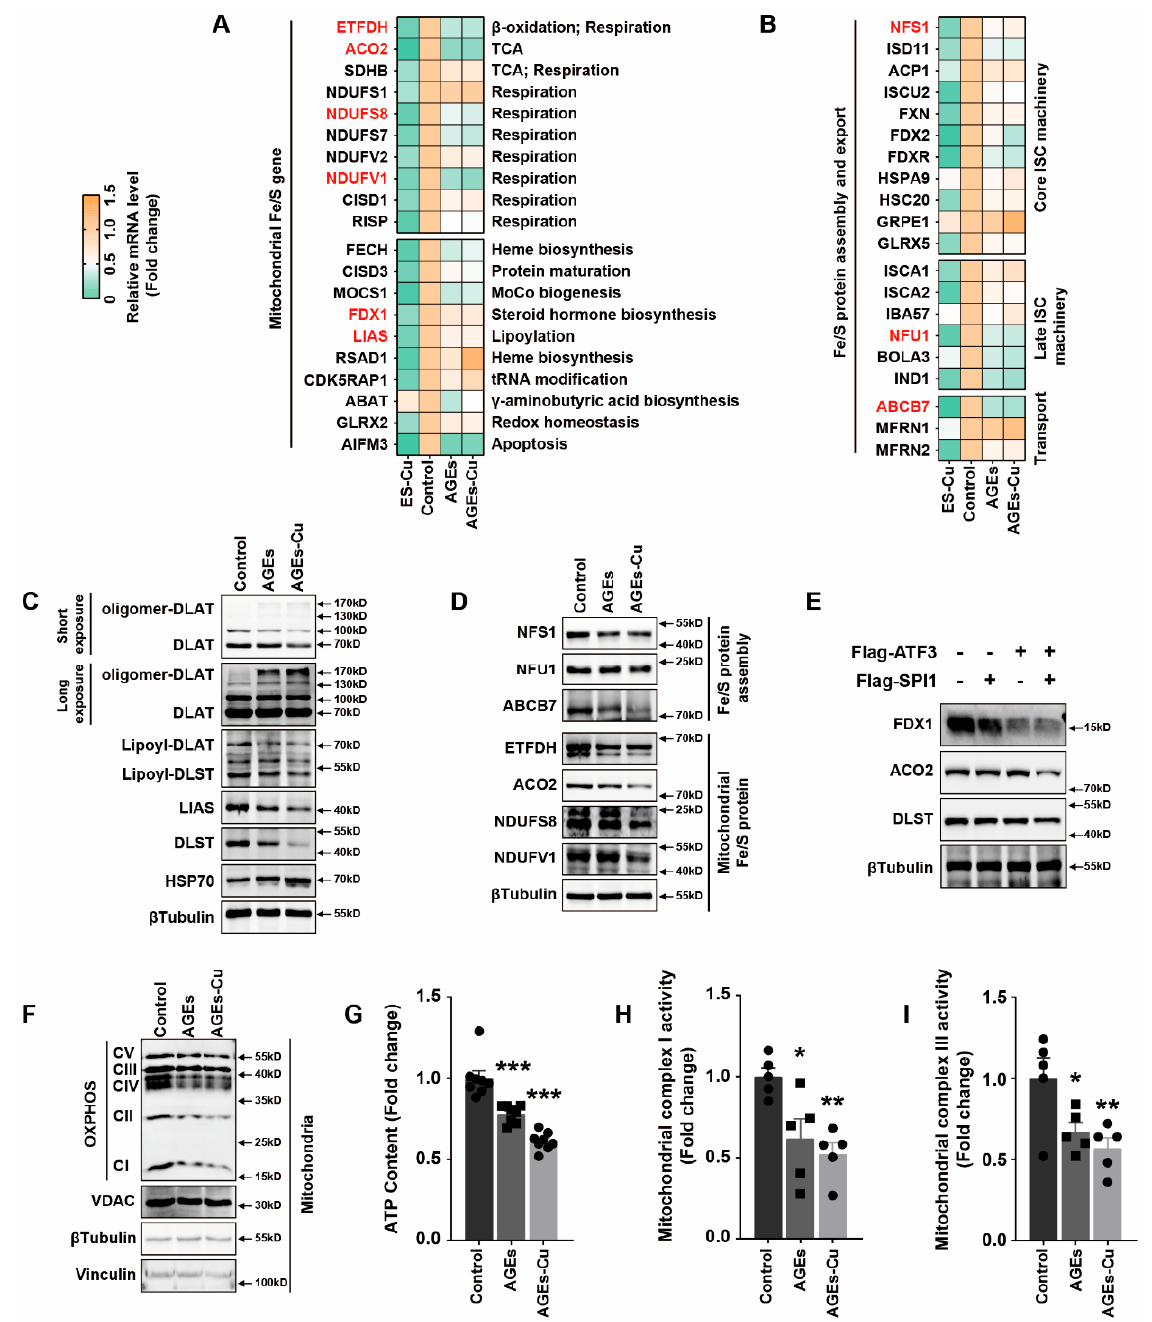
Figure 4. AGEs/ATF3/SPI1/SLC31A1 signaling decreased mitochondrial iron–sulfur cluster protein expression and mitochondrial function. ( A , B ) mRNA levels of mitochondrial iron–sulfur cluster (Fe–S) gene and Fe/S assembly and export in AC16 cells treated with AGEs, AGEs-Cu or ES–Cu for 24 h. ( C ) Western blot analysis of lipoylation and oligomerization of DLAT and DLST, LIAS, DLAT, DLST and HSP70 of AC16 cells treated with AGEs or AGEs–Cu. ( D ) Western blot analysis of iron–sulfur cluster protein in AC16 cells treated with AGEs or AGEs–Cu. ( E ) Western blot analysis of iron–sulfur cluster protein in AC16 cells overexpressed SPI1 and/or ATF3. ( F ) Western blot analysis of mitochondrial oxidative phosphorylation complex of AC16 cells treated with AGEs or AGEs–Cu. ( G – I ) Intracellular ATP content, mitochondrial oxidative respiratory chain complex I and III activity of AC16 cells treated with AGEs or AGEs–Cu. * p < 0.05, ** p < 0.01, *** p < 0.001.